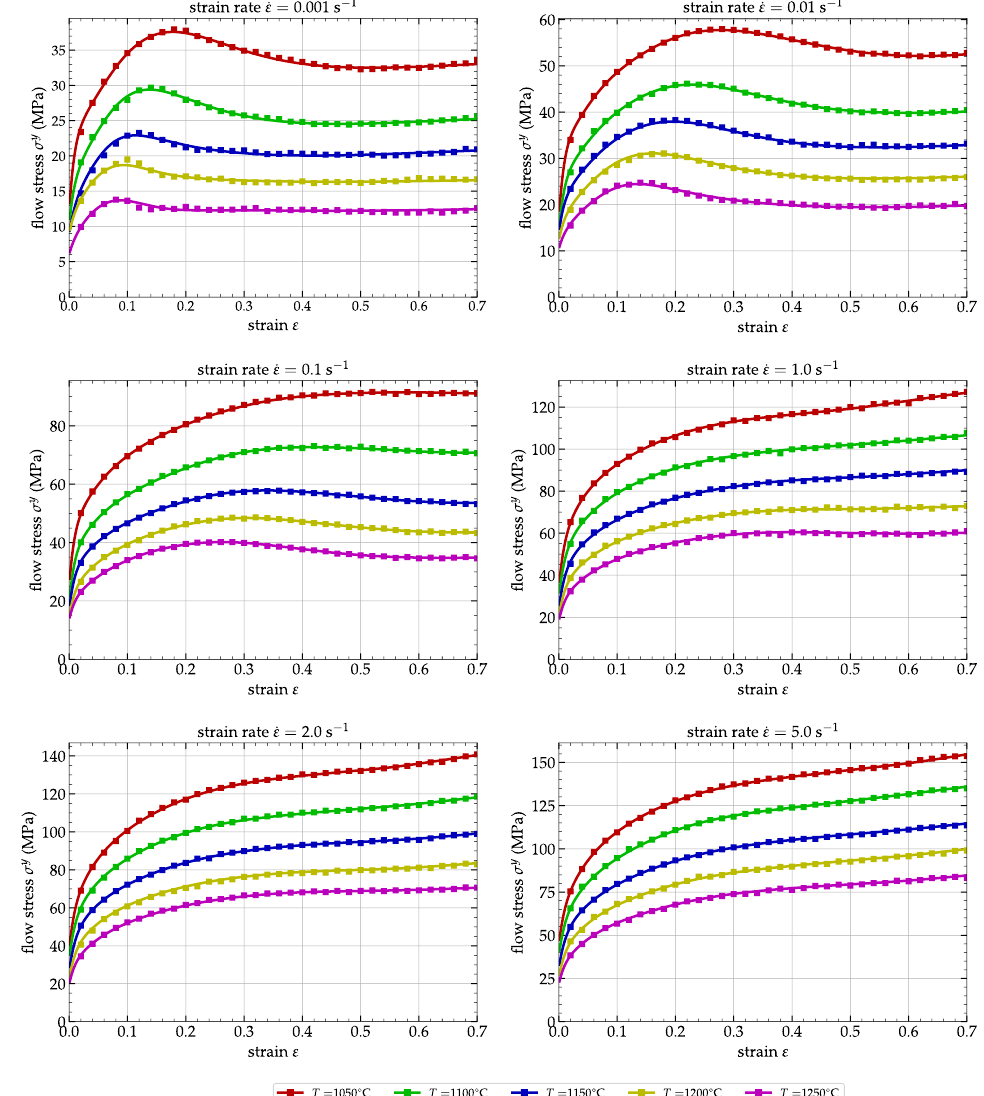
Figure 13. Comparison between the experimental (dots) and predicted (lines) flow stresses σ y by the 3-15-7-1-sigmoid ANN model.